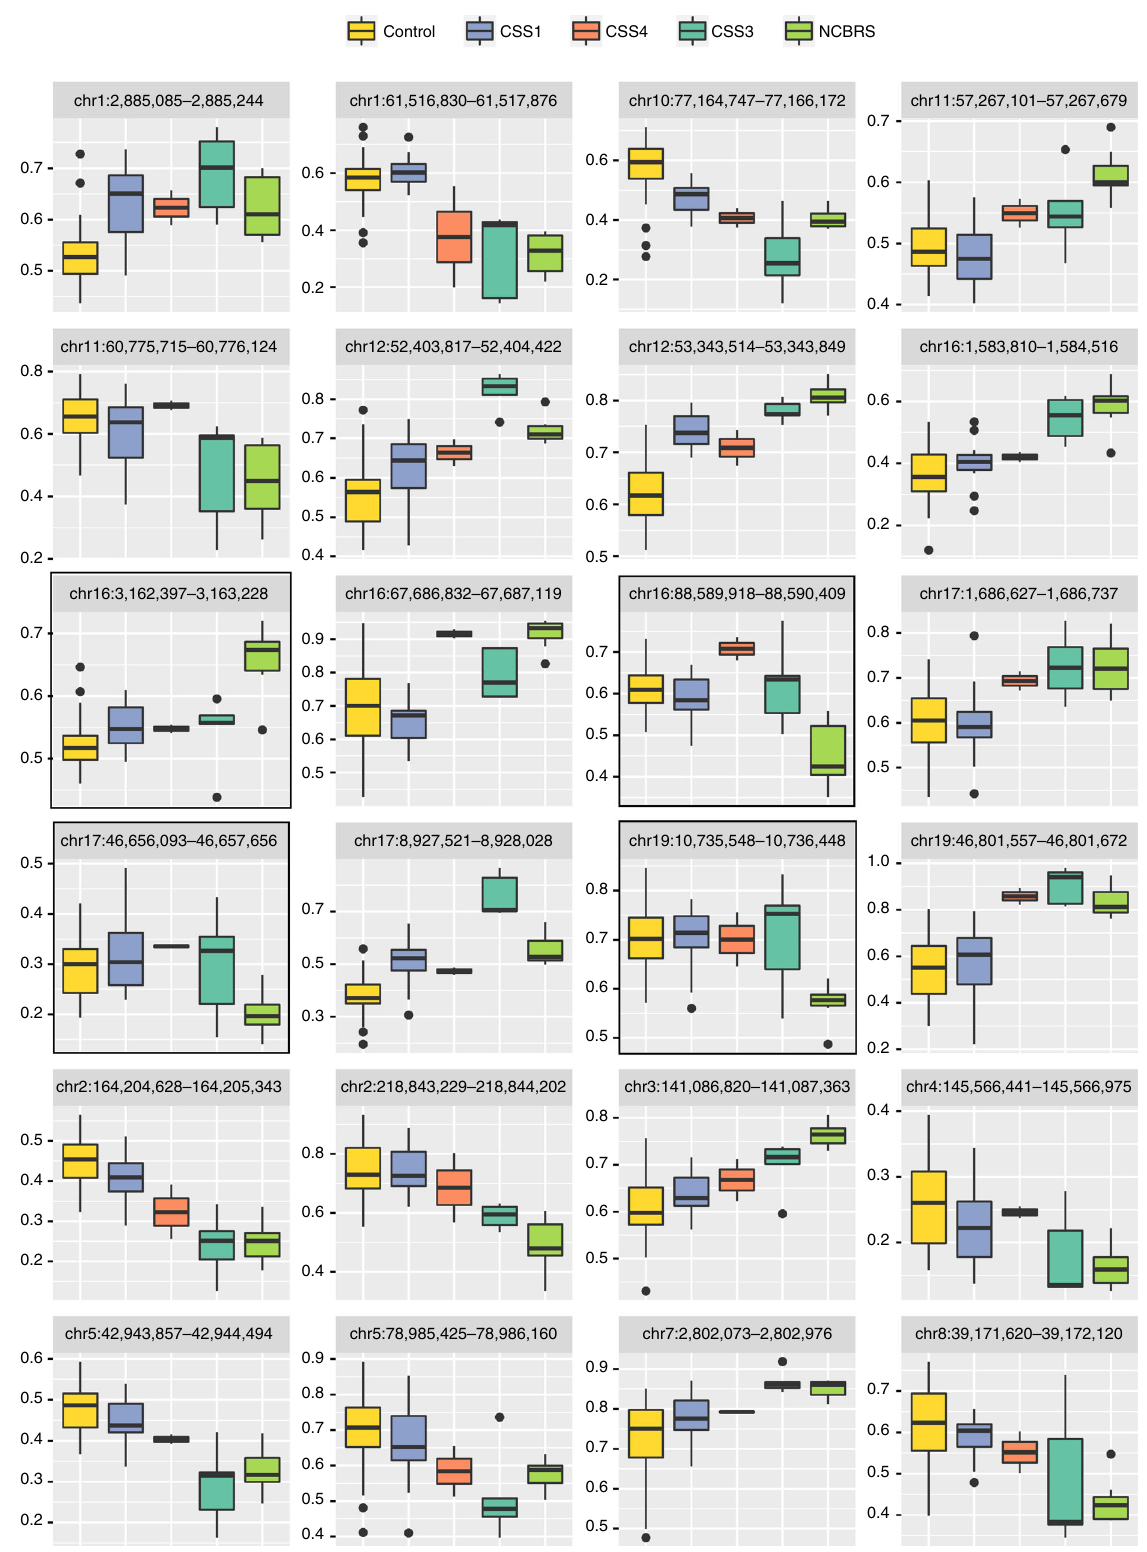
Fig. 6 DMRs differentially methylated in NCBRS. The fi gure shows the entire 24 DMRs found to be differentially methylated in NCBRS cases compared to controls. The box plots represent the distribution of median methylation values across all of the probes mapping to each region as strati fi ed by the subtypes, i.e., Controls, CSS1, CSS4, CSS3, and NCBRS. These regions are detected in the comparison between NCBRS and controls; however, except for four regions (outlined by black squares), all show a similar pattern of hypo/hypermethylation in the CSS3 category. In most cases, when this happens, the identi fi ed trend is more pronounced in CSS3. The CSS1 samples, however, tend to represent the end of a methylation spectrum that is more similar to controls. Center line: median of regional methylation levels across samples; lower and upper bounds: fi rst and third quartiles; whiskers: interquartile